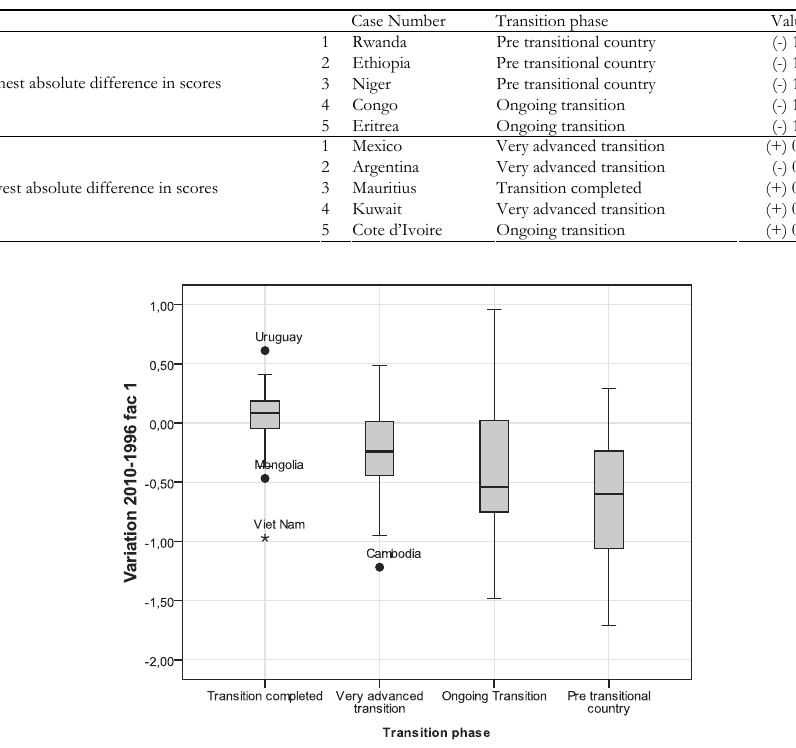
Absolute difference in scores from years 1996 to 2010 for factor 1 – Demographic and development